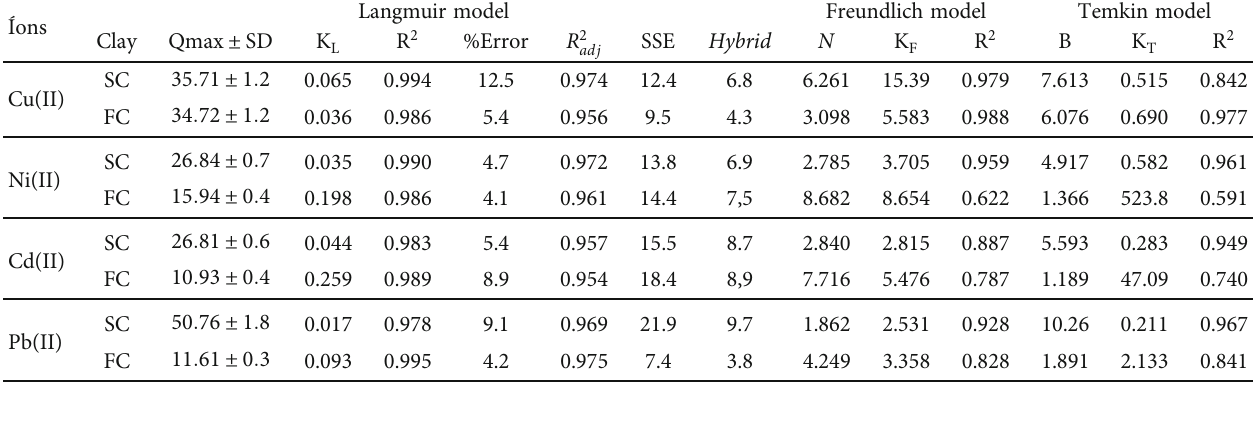
Table 2: Langmuir, Freundlich, and Temkin isotherm models ’ constants and coe ffi cients of determination for adsorption of Cu(II), Ni(II), Cd(III), and Pb(III) onto sodium clay (SC) and ferric clay